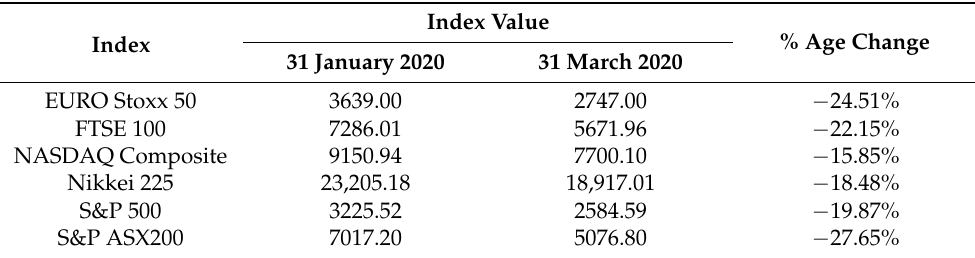
Table 2. This table compares the percentage change in index values of top world indices over the period 31 January 2020 to 31 March 2020. The S&P/ASX200 Index, shaded in grey, declines the most in comparison to top world